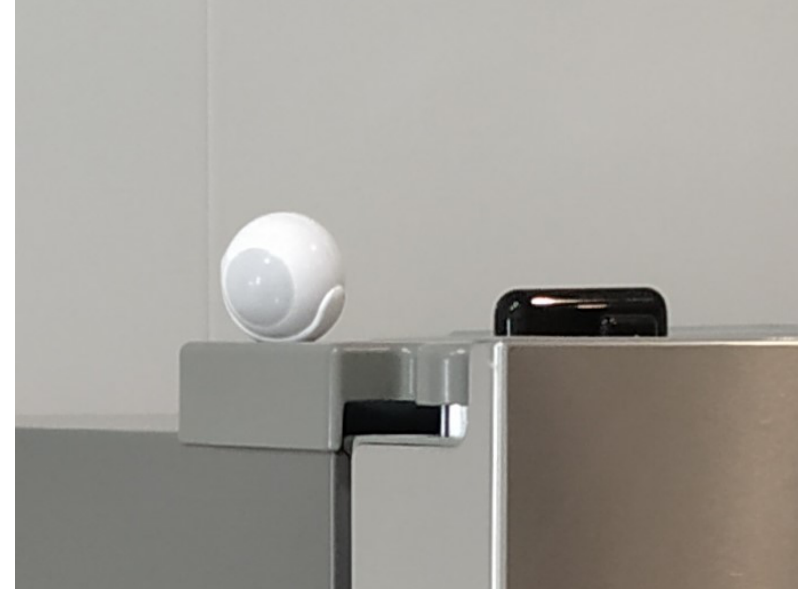
Figure 8. Fibaro Motion Sensor & Door/Window Sensor 2.